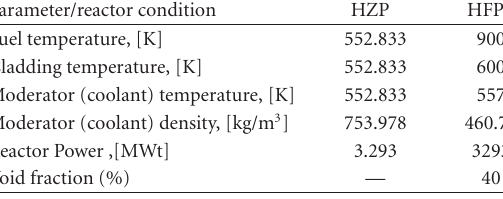
Figure 1: Configuration of PB-2 BWR unit cell.